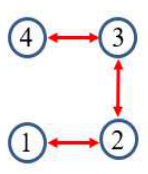
Figure 2. Communication scheme related to the partitioned